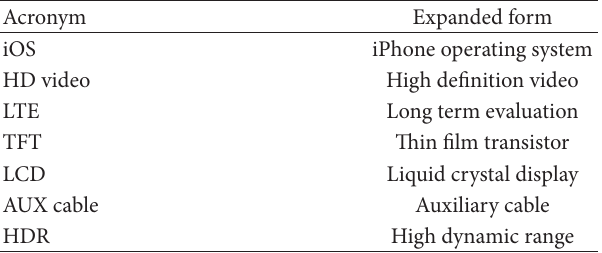
Table 1: Partial list of acronyms for